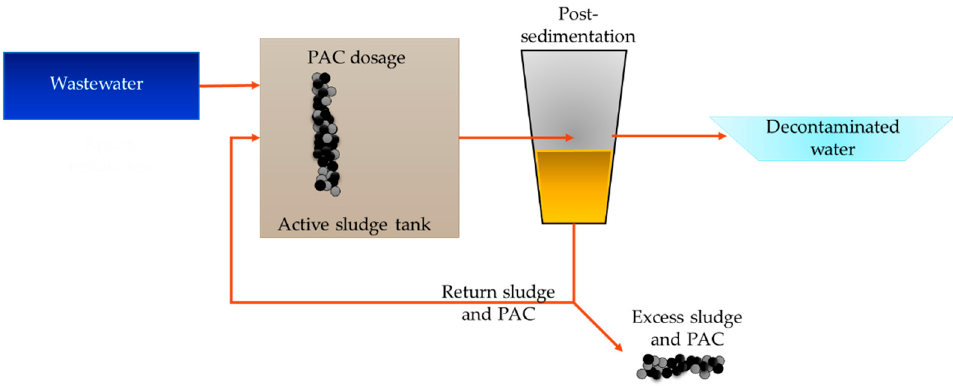
Figure 3. Knockdown operation with PAC and GAC